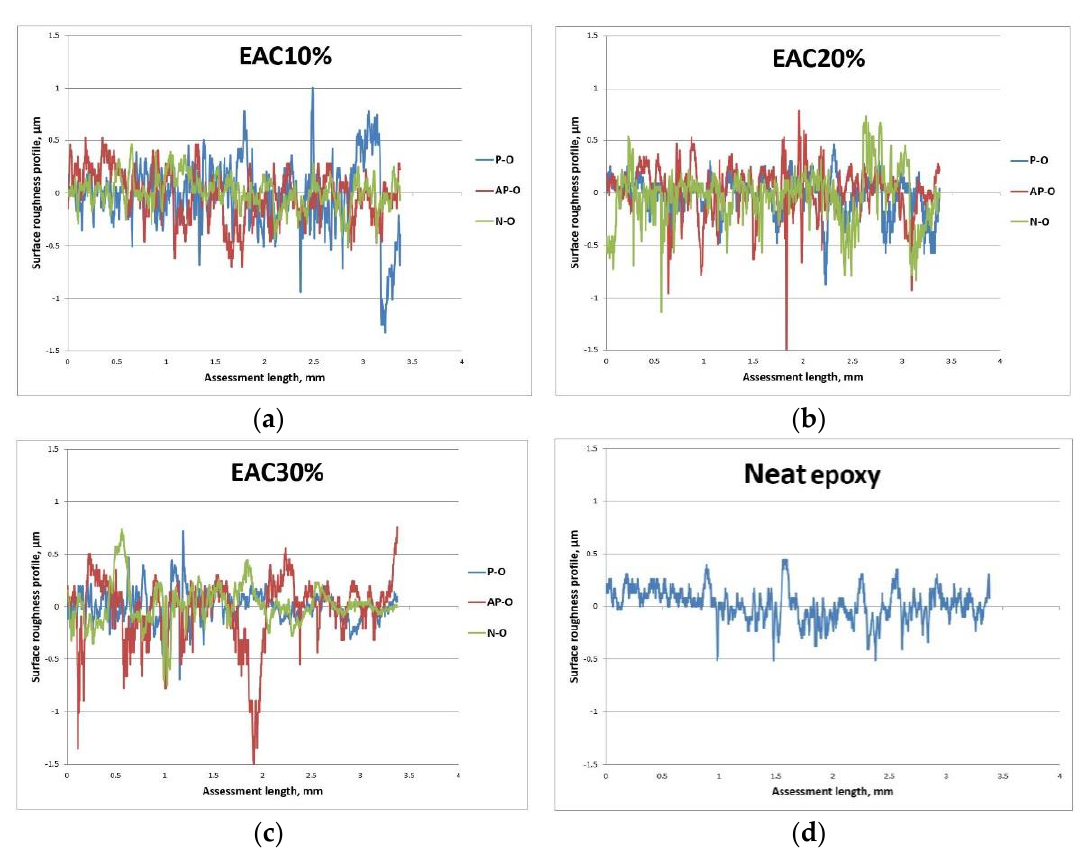
Figure 4. Contact surface roughness of samples per volume fraction of abaca fiber: ( a ) parallel, ( b ) anti-parallel, ( c ) normal and ( d ) neat epoxy.